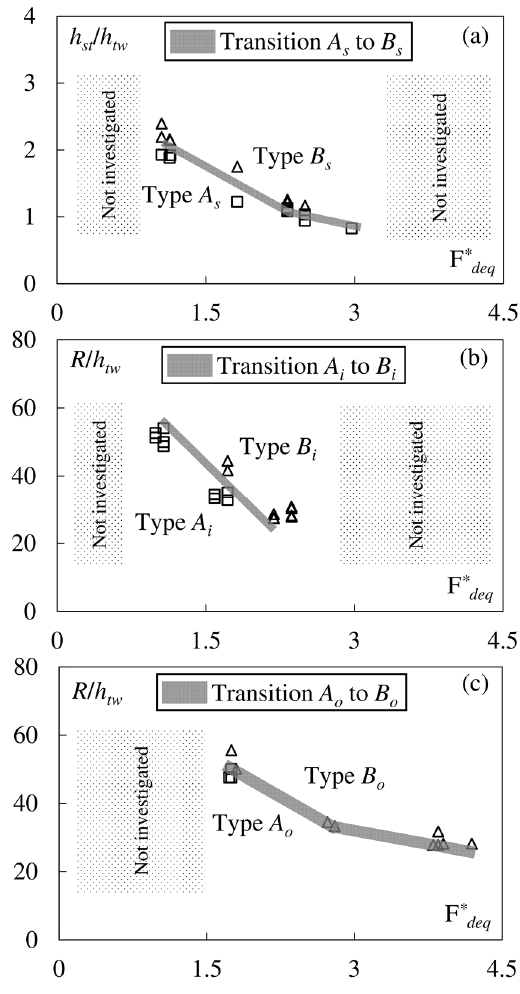
Figure 11. Scour maps for ( a ) test 4, having Type A s , and ( b ) test 3, having Type Bs . All dimensions are in metres, and the flow is from left to right.